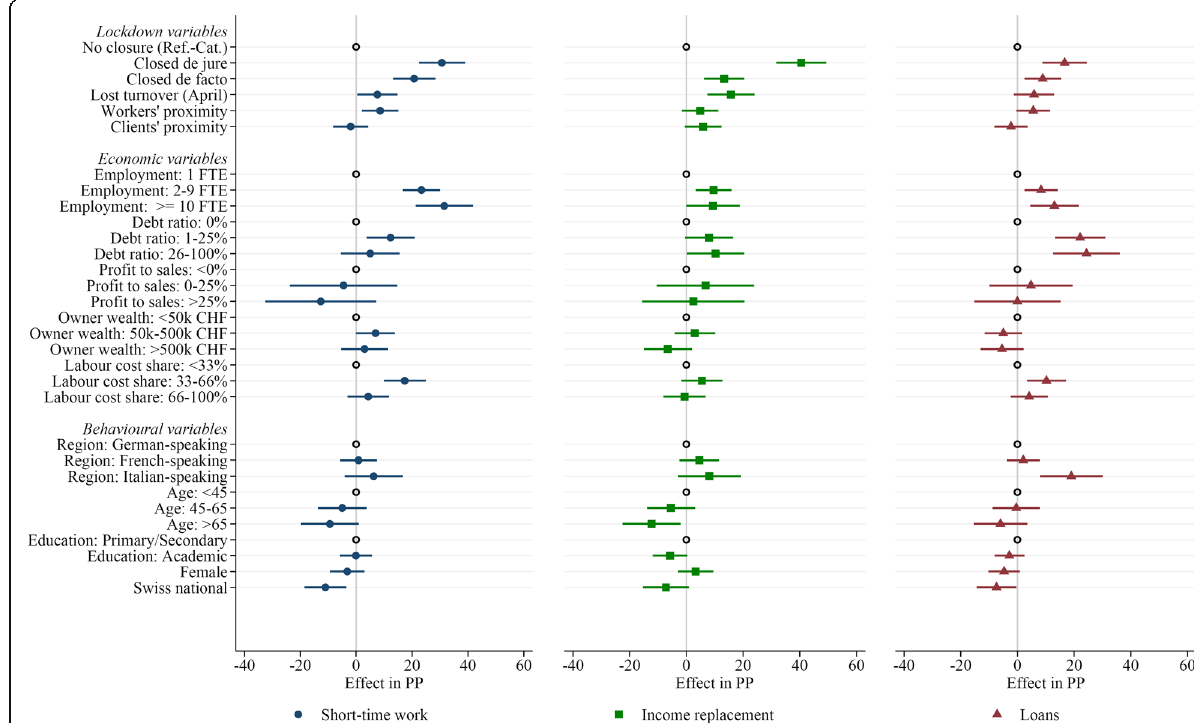
Fig. 2 Determinants of the use of support measures (illustration of estimated coefficients).The graphs show coefficient estimates and 95% confidence intervals as reported in column (5) of Tables 2, 3 and